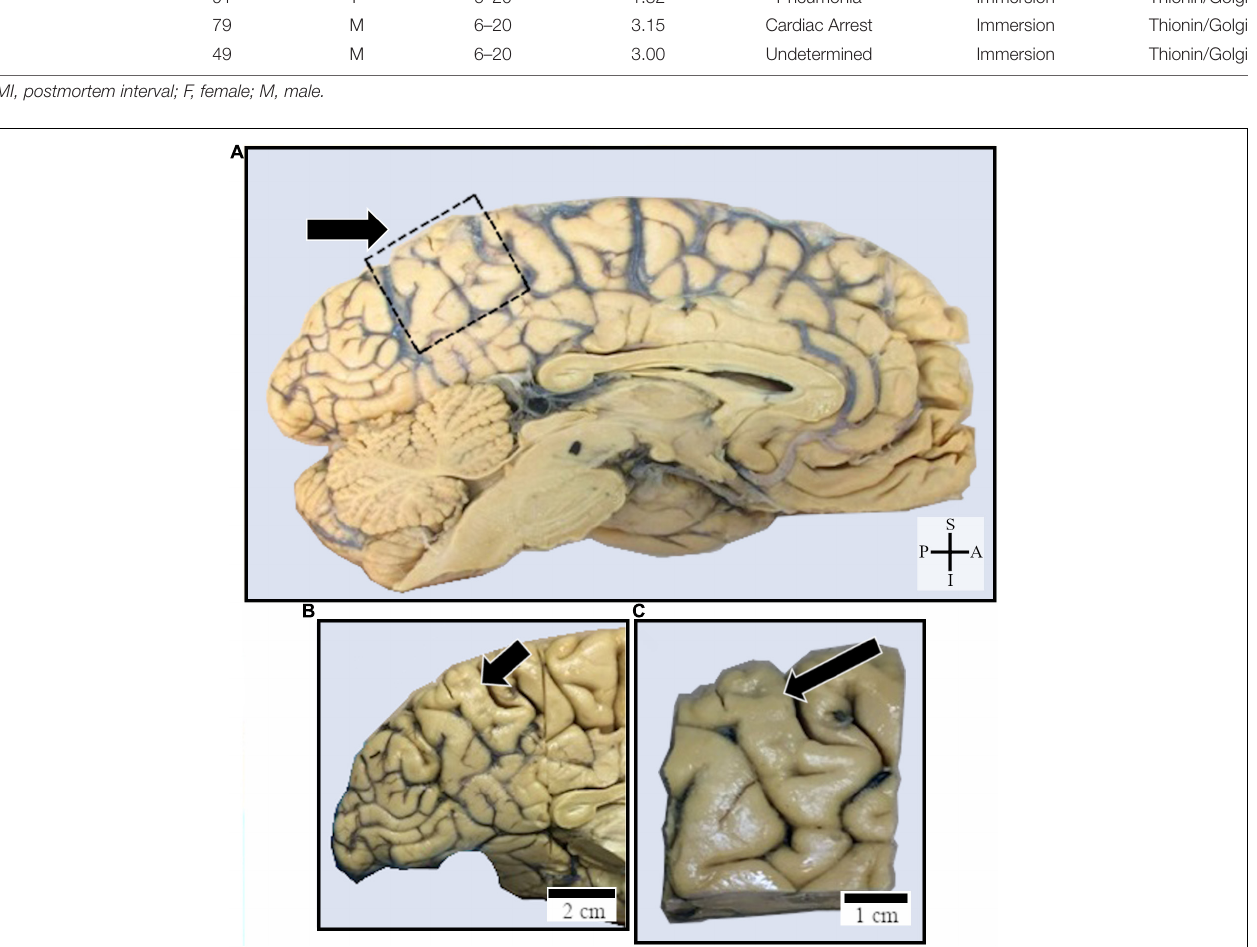
FIGURE 1 | (A) Midsagittal section to show the macroscopic location of the human posteromedial cortex where the precuneus (PC, pointed by an arrow and delimited within a dashed square) was studied near the transition zone to the posterior cingulate cortex. (B,C) Higher magnification images of the human PC where samples were obtained for the identification of spindle-shaped neurons in cortical layer V (shown in the following figures). Coordinates: A, anterior; I, inferior; P, posterior; S, superior. Scales are shown in the